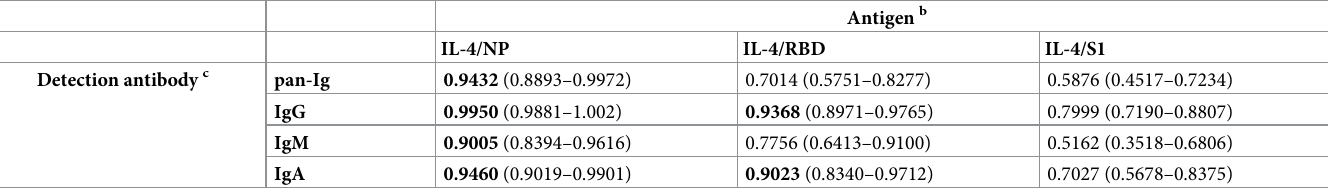
Table 2. Area under the ROC curve (AUC) for each SARS-CoV-2 antigens and detection antibodies in the COVID-19 multiplex assay a